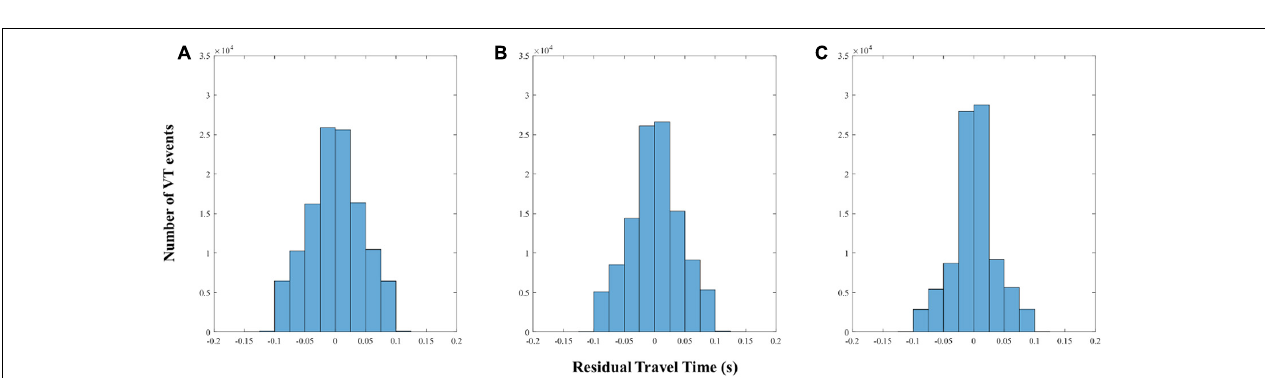
FIGURE 6 | Map of epicenters of VT earthquakes preceding the 2017 Agung volcanic eruption. (A) Initial locations derived using a non-linear approach. (B) Updated epicenter distribution after updated 1D velocity model, and (C) after DD relocation. In (B) and (C) only events with uncertainty less than 5 km are shown. Purple and blue circles represent events during (October 2017) and after seismic crisis (November 2017), respectively.